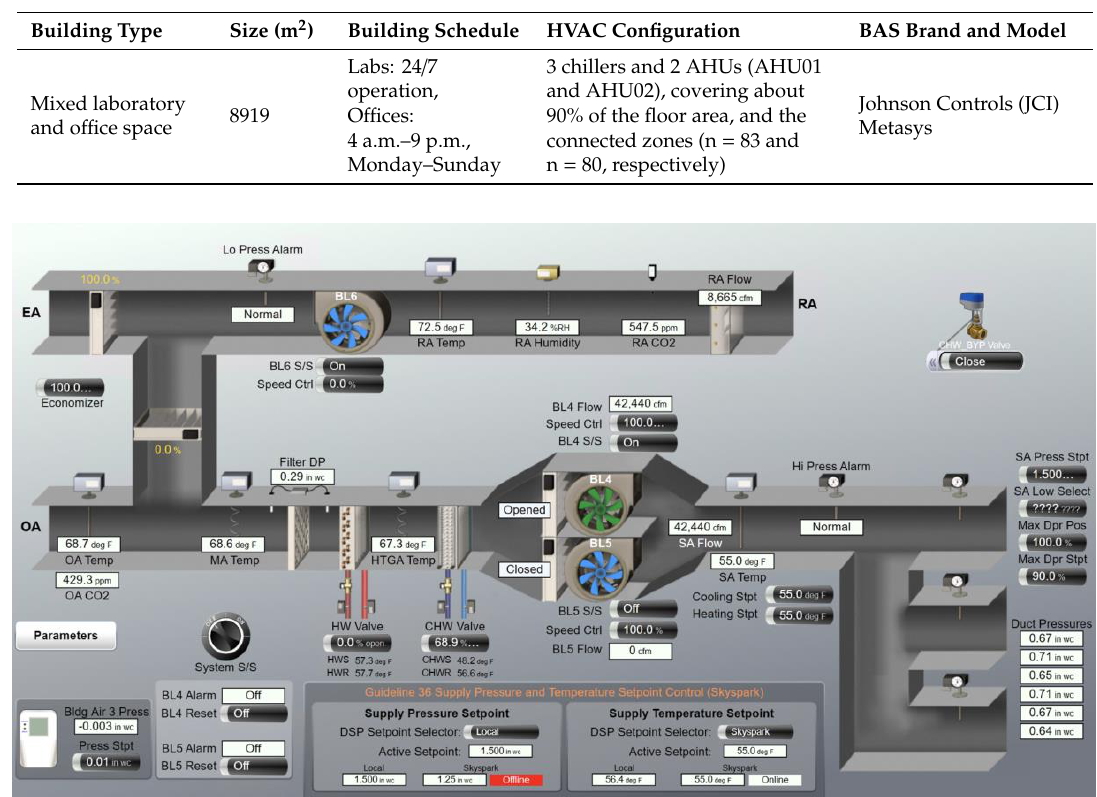
Table 2. Test site information.